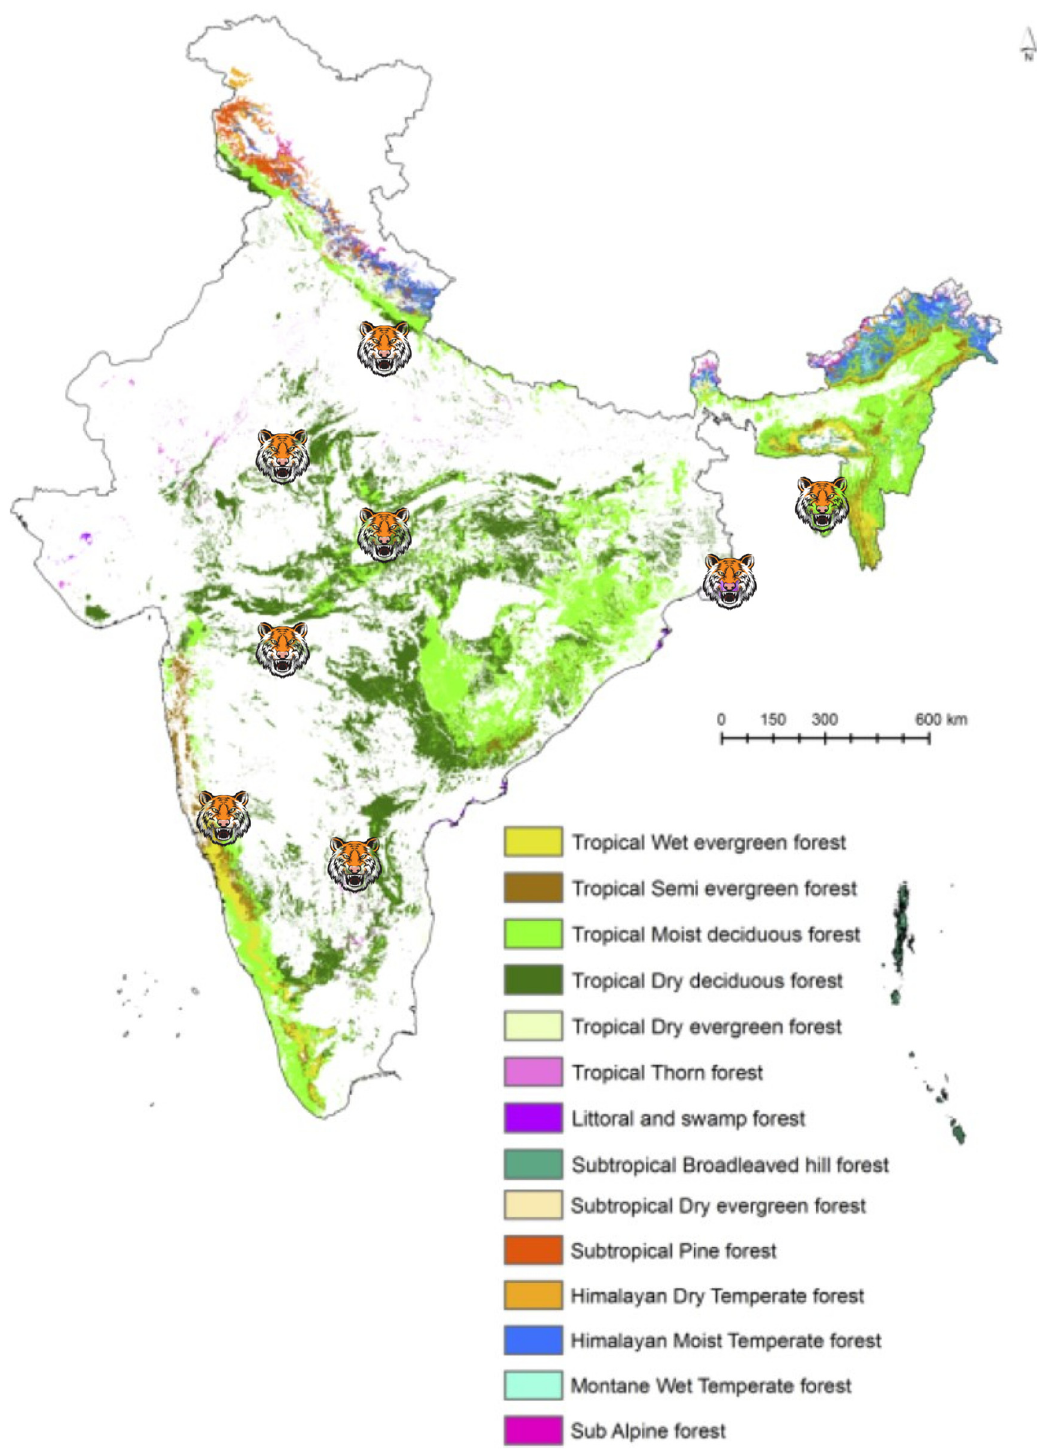
Figure 6: Map of India showing the regions of major conservation studies along with the type of vegetations found in these